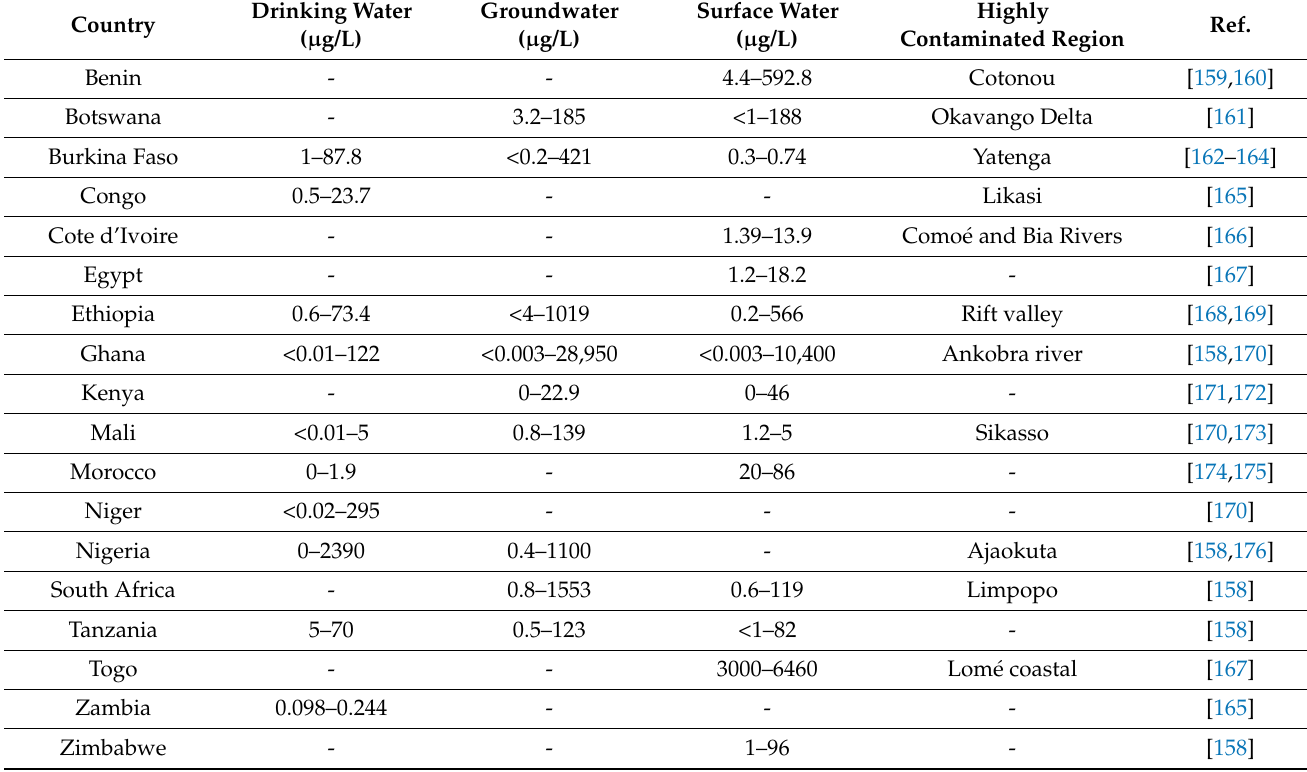
Table 8. African regions and concentrations of arsenic in water sources (selected data from recent